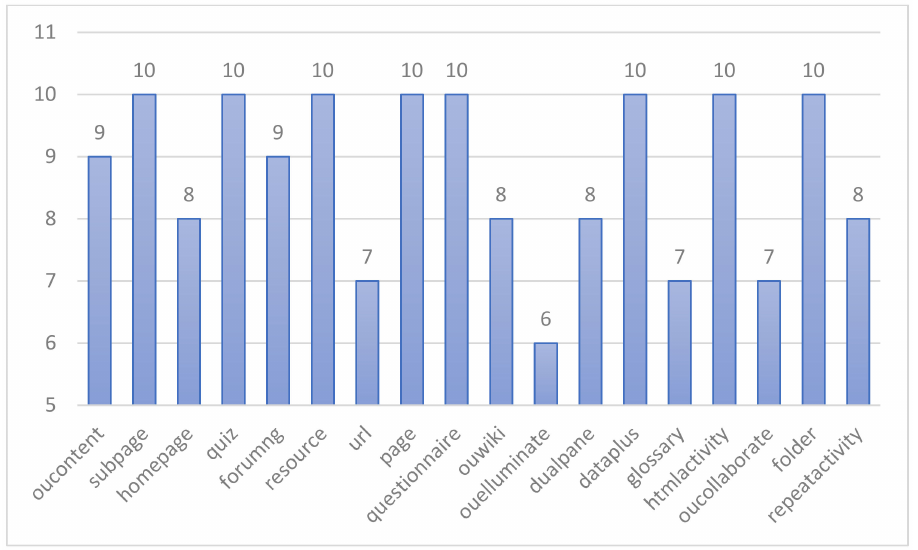
Figure 6. Diagram of feature space of ten FGDEM runs.